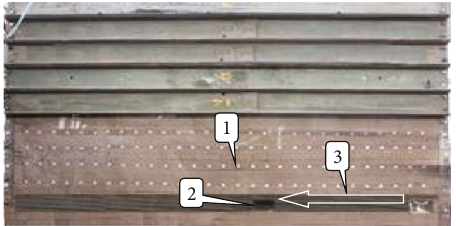
Figure 2: The experiment device. 1 — displacement measuring point; 2 — abandoned roadway; 3 — advancing direction of working face.